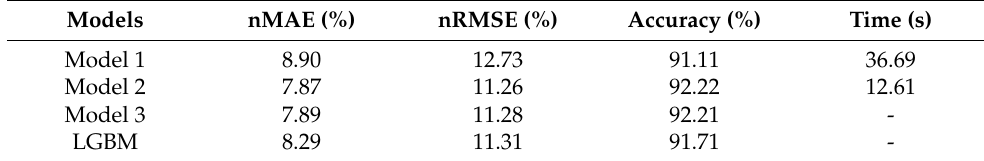
Table 7. Experimental comparison